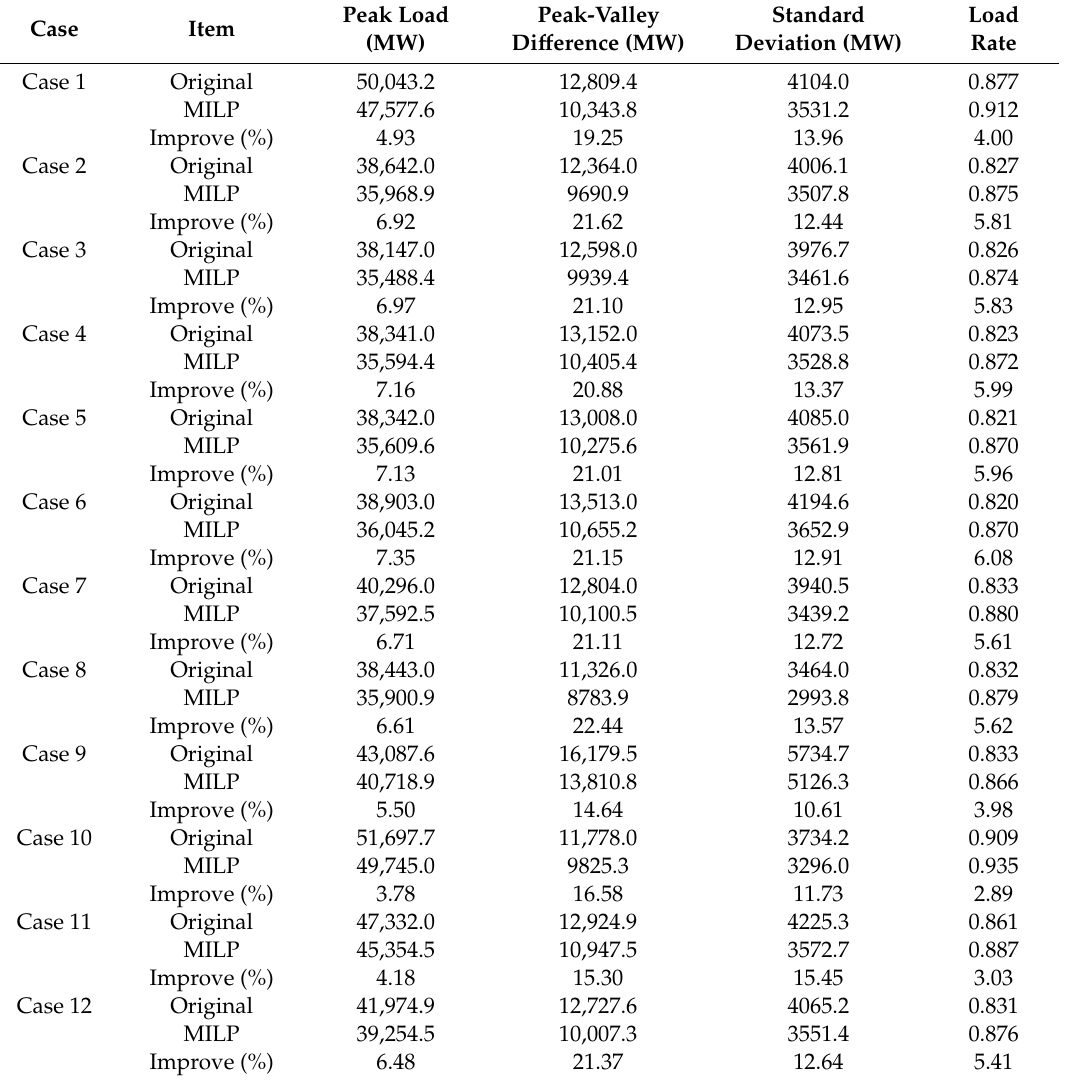
Table 6. Comparison of the original load and the optimized load obtained by MILP in Case